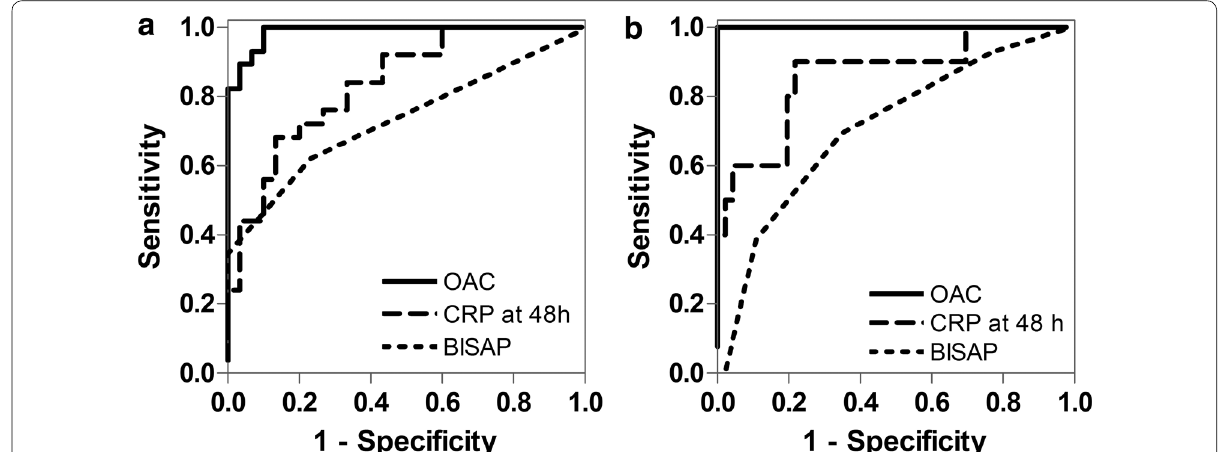
Fig. 3 ROC curves of oleic acid chlorohydrin (OAC), C‑reactive protein (CRP) and BISAP score for the prediction of acute pancreatitis severity. a ROC curve for the prediction of moderately severe‑to‑severe disease. b ROC curve for the prediction of severe disease. OAC oleic acid chlorohydrin. CRP